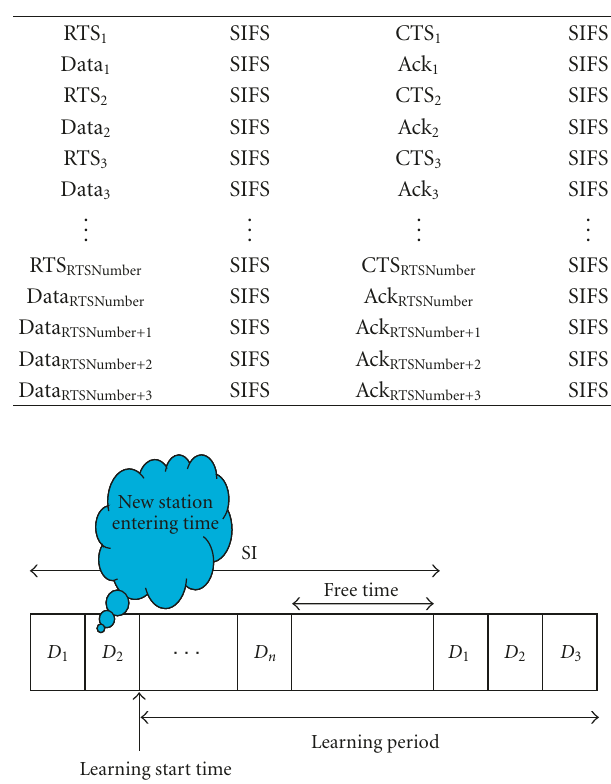
Table 1: Data transmission sequence for a specific TS in AFDGP.